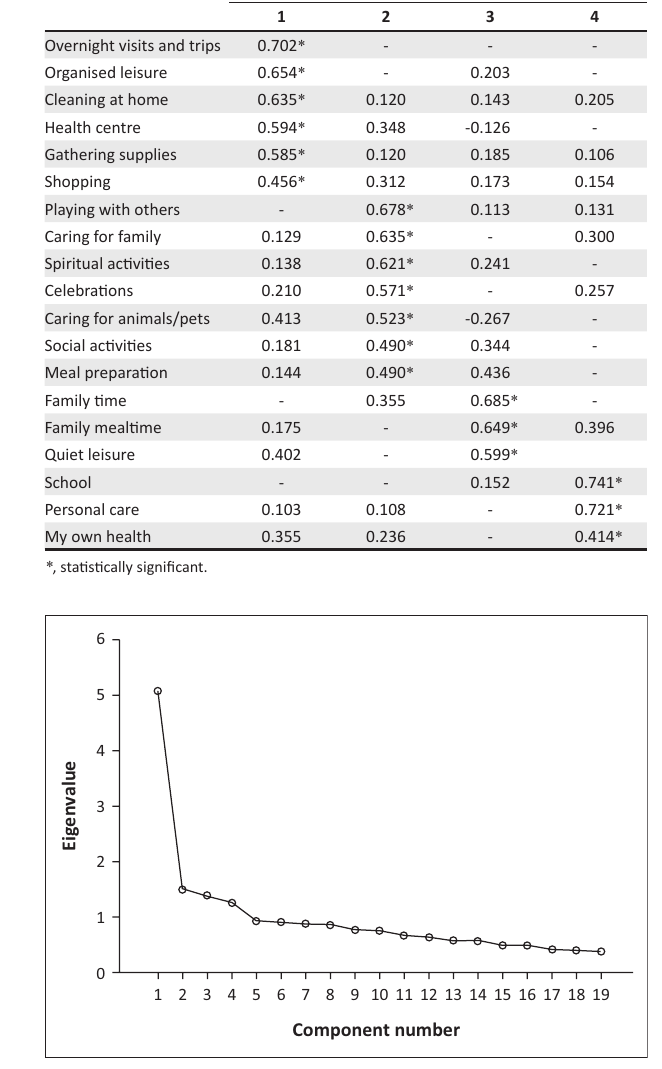
FIGURE 1: Component matrix demonstrating four components that are evident in the data set. Scree